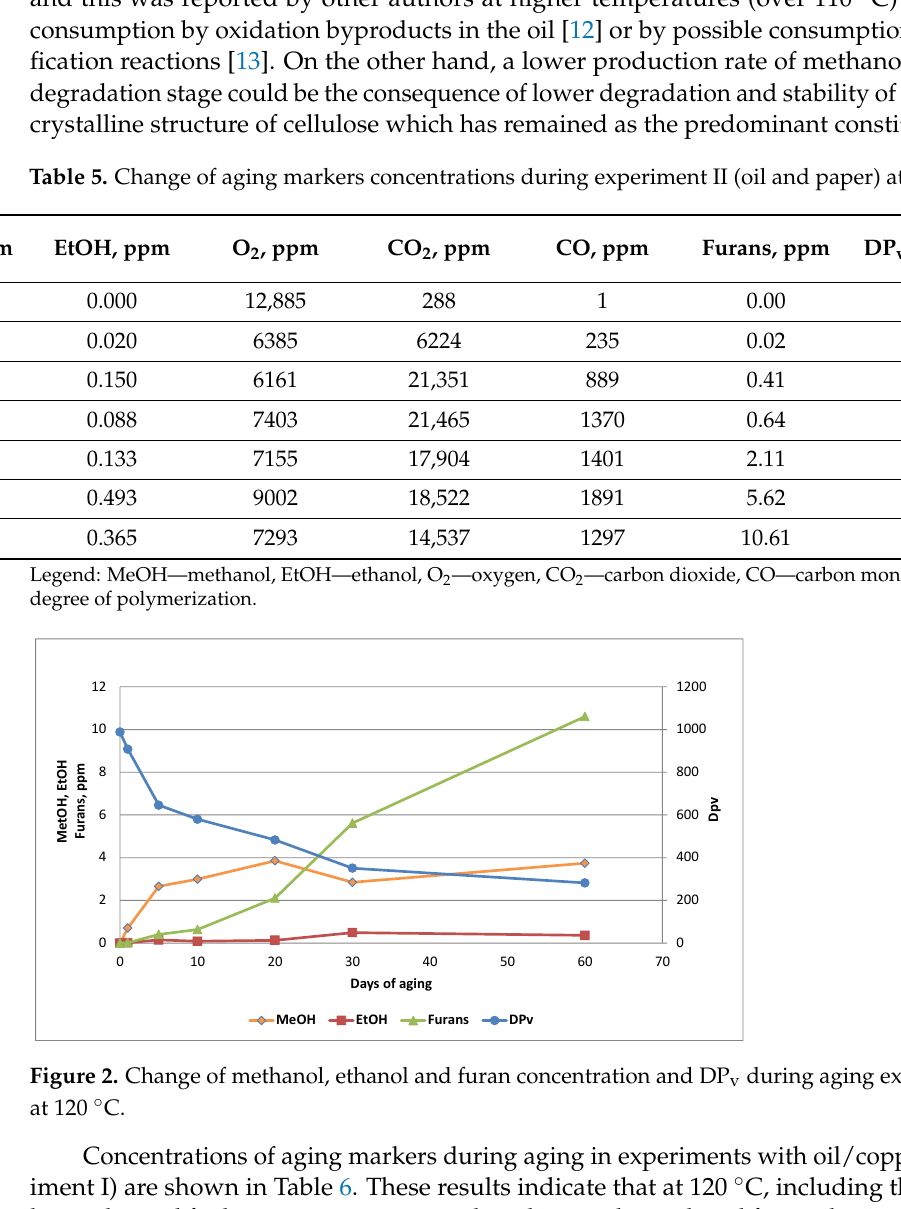
Table 6. Change of aging markers concentrations during Experiment I (oil only) at 120 °C.